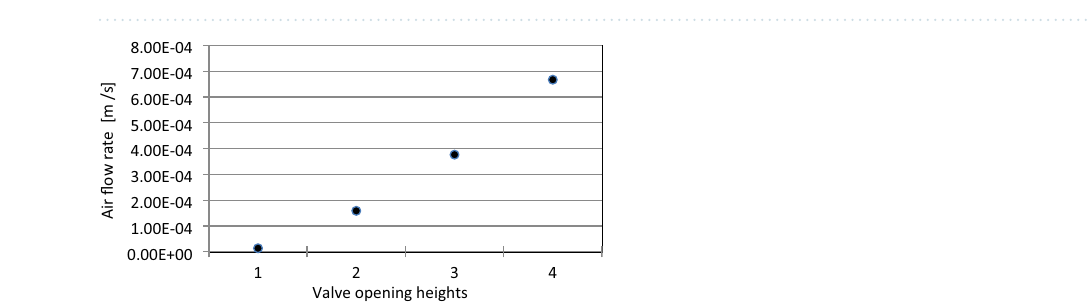
3 m, 4 h 1.43 10 3 − − = ×